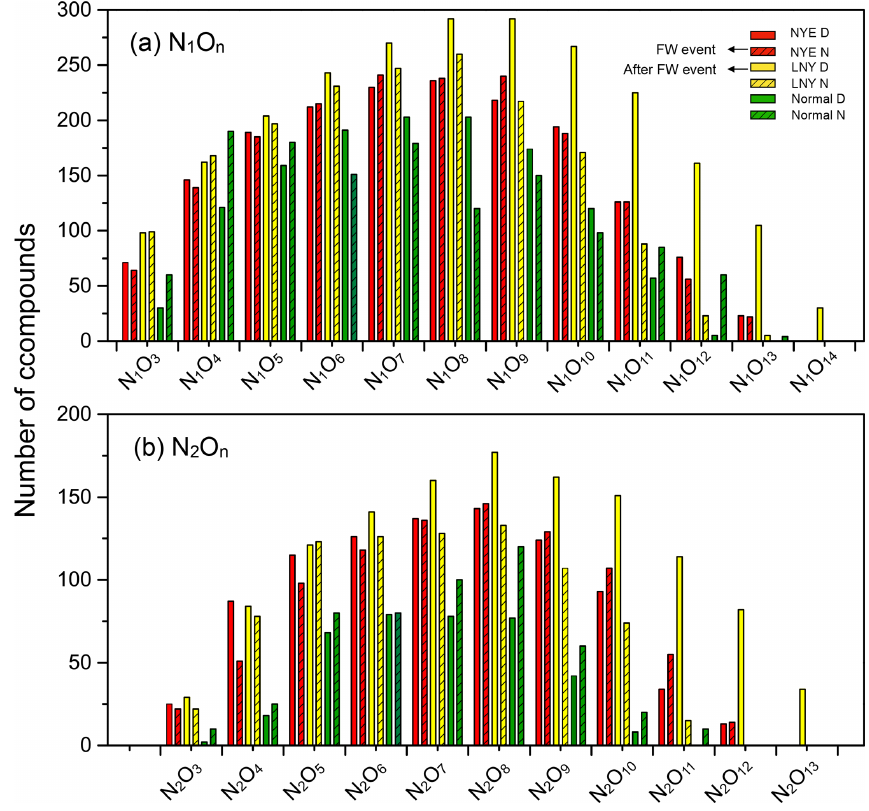
Figure 7. Classification of CHON species into subgroups according to the number of N and O atoms in their